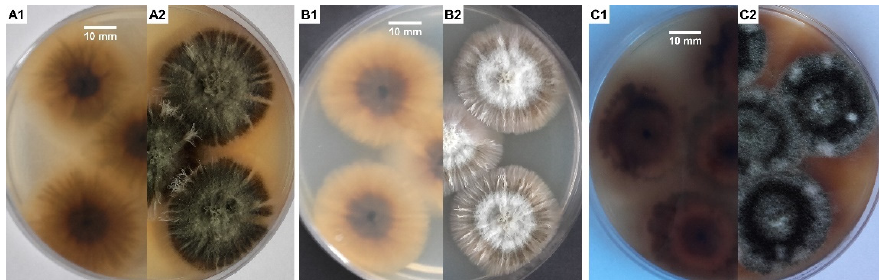
Figure 1. According to literature [12,22,34,53,54,56], these images are typical for Stachybotrys chartarum morphology of colony after 10 days incubation at 25 °C on the following: PDA medium ( A1 , A2 ); MEA ( B1 , B2 ); PDA + MEA, with the combination of media in a ratio of 1:1 ( C1 , C2 ), respectively, reverse/averse; strain isolated from gypsum board in flooded home, Cracow, Poland ( S. chartarum MD1/2021). Photos by the author.